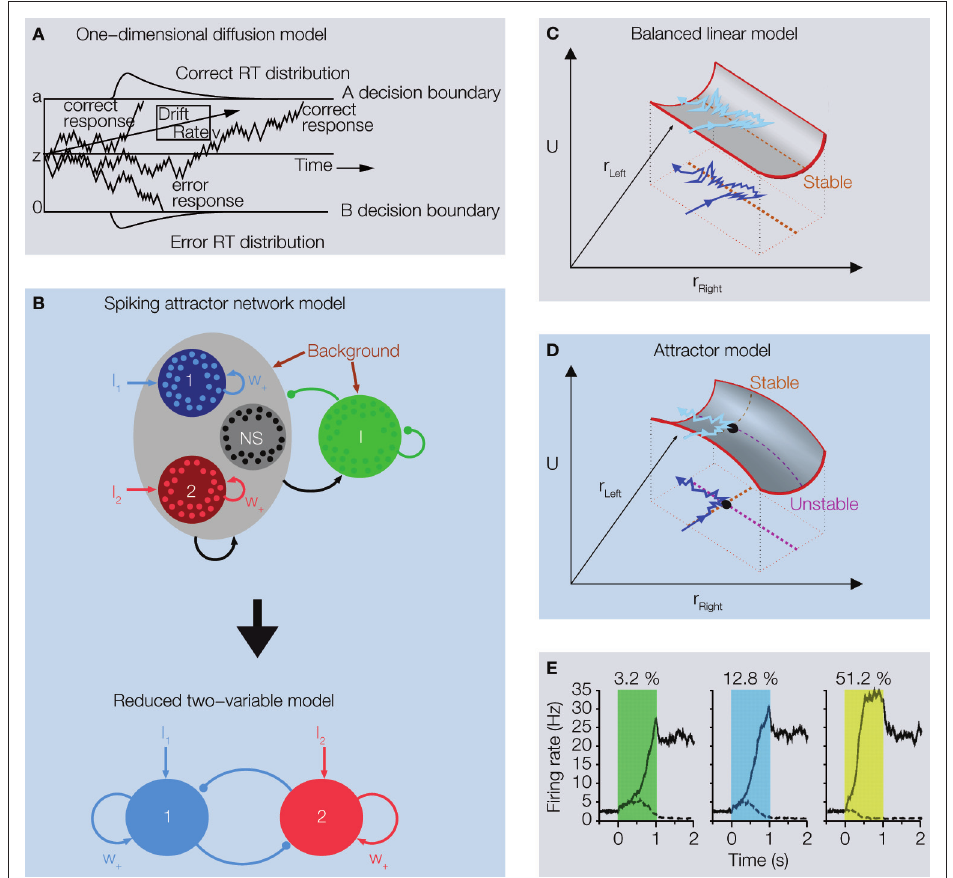
Figure 2 | The diffusion and the attractor models in two-choice tasks. (A) Basic features of a one-dimensional drift-diffusion model of Ratcliff (1978) for two-choice reaction time tasks. (B) Network architecture of Wang (2002) (top), and its reduced “mean-field” version (Wong and Wang, 2006) (bottom). (C,D) “Potential landscapes” of models in decision firing rate space and its 2-dimensional projection during sensory integration. U: “potential” of the system. r and r : neural activity of populations selective to leftward and rightward motion, respectively. Sensory stimulus Left Right is unbiased for clearer illustration. (C) Linear neural network model with large and balanced decay and inhibition can exhibit approximately one-dimensional diffusion-like processes. (D) Attractor model which has an unstable saddle-like steady-state (black filled circle) that is associated with a stable and unstable “manifold” that direct the network dynamics in two dimensions. (E) Persistent neural activity of the model in Wong and Wang (2006) showing the formation of the decision (0–1 s) and sustaining the categorical memory of decision made during the delay period (1–2 s), in a task similar to Shadlen and Newsome (2001). Left-right: motion coherences of 3.2%, 6.4% and 12.8%. (A) adapted from Ratcliff and McKoon (2008), with permission; (B,E) from Wong and Wang (2006), with permission. See text for